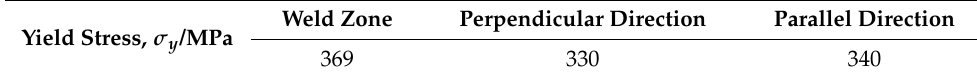
Table 4. Yield stress determined by the conventional tensile